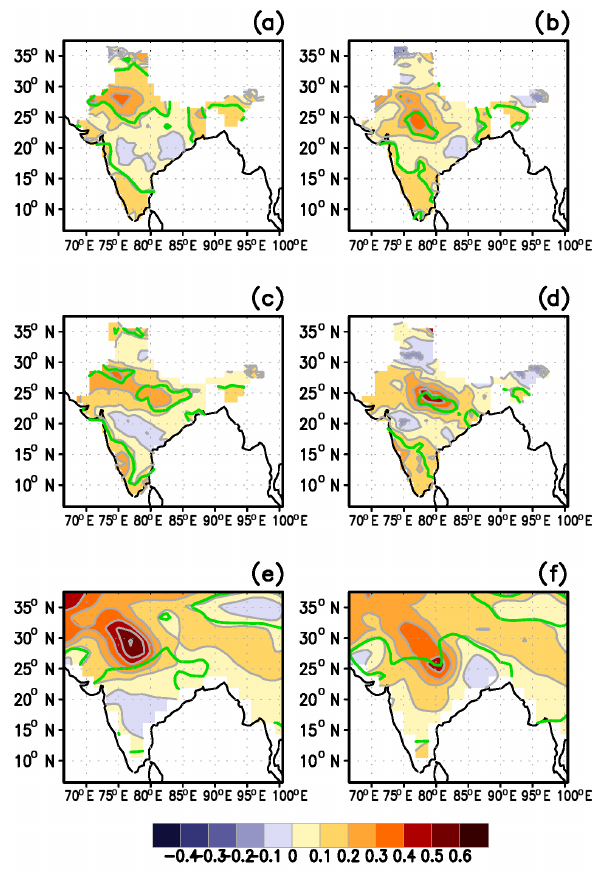
Figure 3. Observed trend (1969–2005) in seasonal (JAS) 2m air temperature from IMD (in ◦ Cdecade − 1 ). Trend in (a) seasonal av- erage of daily mean, (b) 90th percentile of daily mean, (c) seasonal average of daily maximum, and (d) 90th percentile of daily maxi- mum temperature. Observed trend (1951–2005) in (e) seasonal av- erage of daily mean and (f) 90th percentile of daily mean 2m air temperature from 20CR reanalysis data (in ◦ Cdecade − 1 ). Green contour encloses the region where trends are significant at the 90% confidence